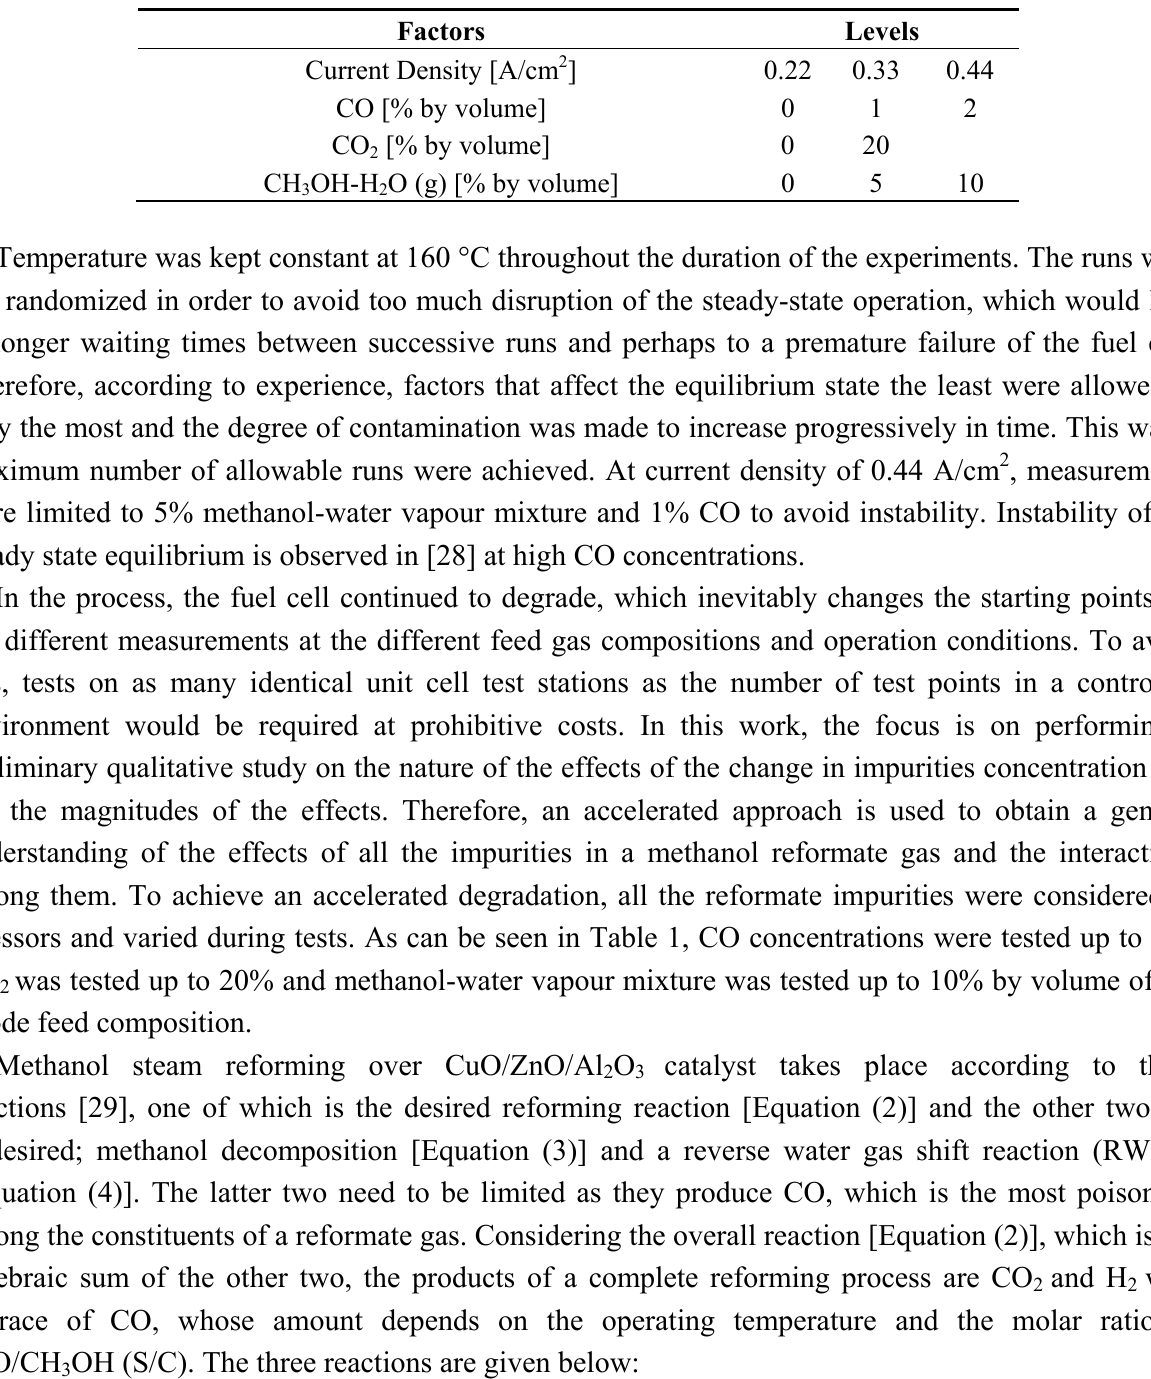
Table 1. The different factors and their levels used for the factorial design of